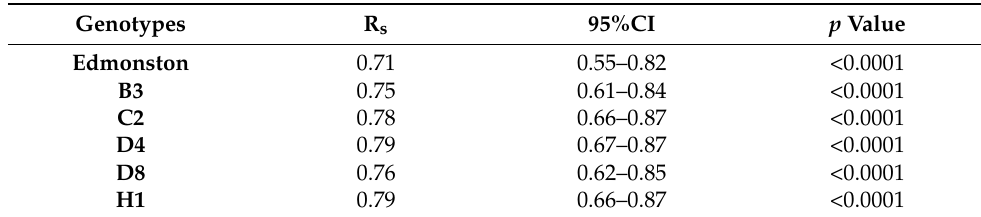
Table 3. Spearman’s rank correlation coefficient between IgG levels (measured by kit from EUROIMMUN ® ) and neutralising antibody